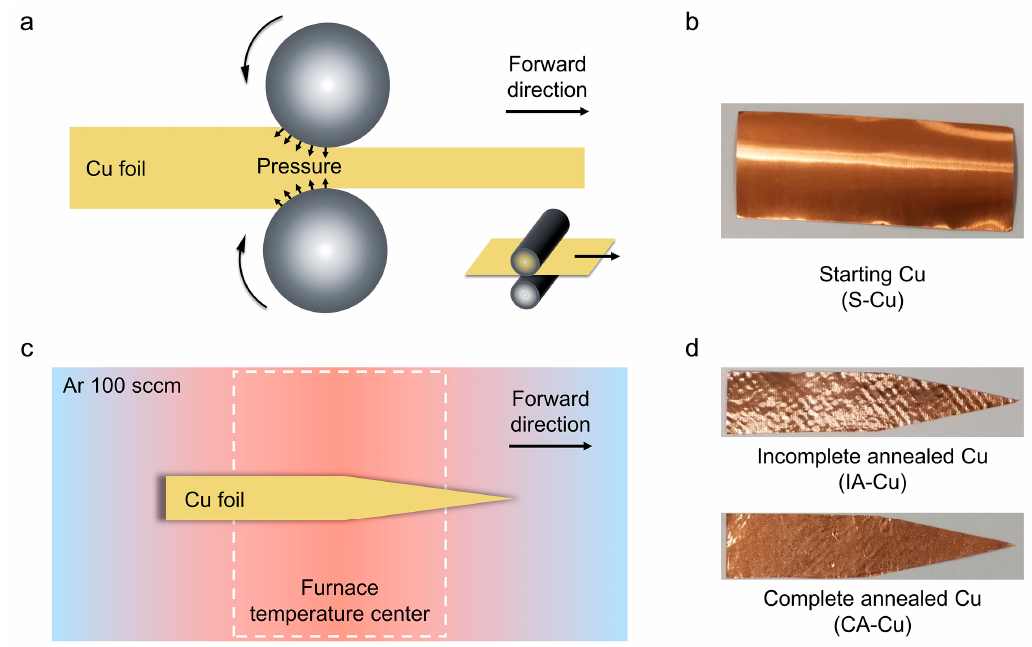
Scheme 1. Preparation of copper foils. ( a ) and ( c ) are schematic diagrams of rolling process and temperature gradient annealing process, respectively; ( b ) and ( d ) are photographs of S-Cu, IA-Cu, and CA-Cu,